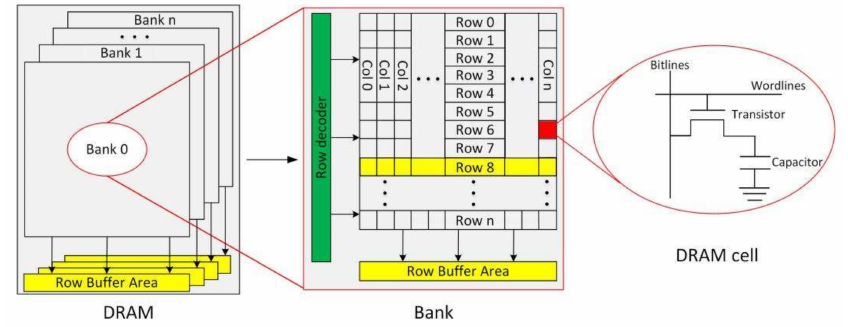
Figure 1. Dynamic random-access memory (DRAM) architecture.